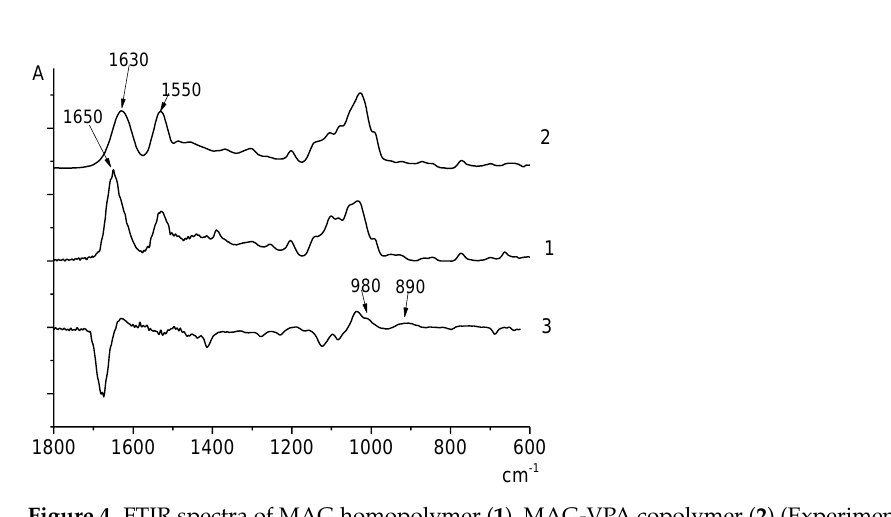
5 of 14 Figure 2. FTIR spectra of VPA homopolymer ( a ), AA homopolymer ( b ,1), AA-VPA copolymer (Experiment 11, Table 1) ( b ,2). The spectrum of poly(4-acryloylmorpholine) contains the characteristic bands at 1620 cm −1 (amide I) and 1113 cm – 1 (related to vibrations of the C-O-C fragment of the cy- clic ether). Unlike the bands of the 4-AM units, the bands related to the VPA units in the spectrum of the 4-AM-VPA copolymer are poorly resolved; for the purpose of the de- tailed study of these peaks, the difference spectrum of the 4-AM-VPA copolymer and poly(4-acryloylmorpholine) was obtained. In this spectrum, the peaks at 1155 cm −1 , 980 cm −1 , and 920 cm −1 , typical for the VPA units, were observed (Figure 3). 15001000 0 , 0 0 , 1 0 , 2 0 , 3 0 , 4 0 , 5 0 , 6 0 , 7 0 , 8 0 , 9 1 , 0 1 , 1 A c m - 1 2 1 980920 11553 Figure 3. FTIR spectra of poly(4-acryloylmorpholine) (1), 4-AM-VPA copolymer (Experiment 5, Table 1) (2), the difference spectrum (3). The spectrum of the MAG homopolymer (Figure 4) contains the characteristic amide I (1650 cm −1 ) and amide II (1550 cm −1 ) bands, as well as the peak related to the vibrations of the glycoside ring (1000 cm – 1 ). The amide I band of the MAG units in the spectrum of the MAG-VPA copolymer becomes less intense, and it is widened and shifted (from 1650 cm −1 to 1630 cm −1 ); besides, the shape of the band attributed to the glycoside ring near